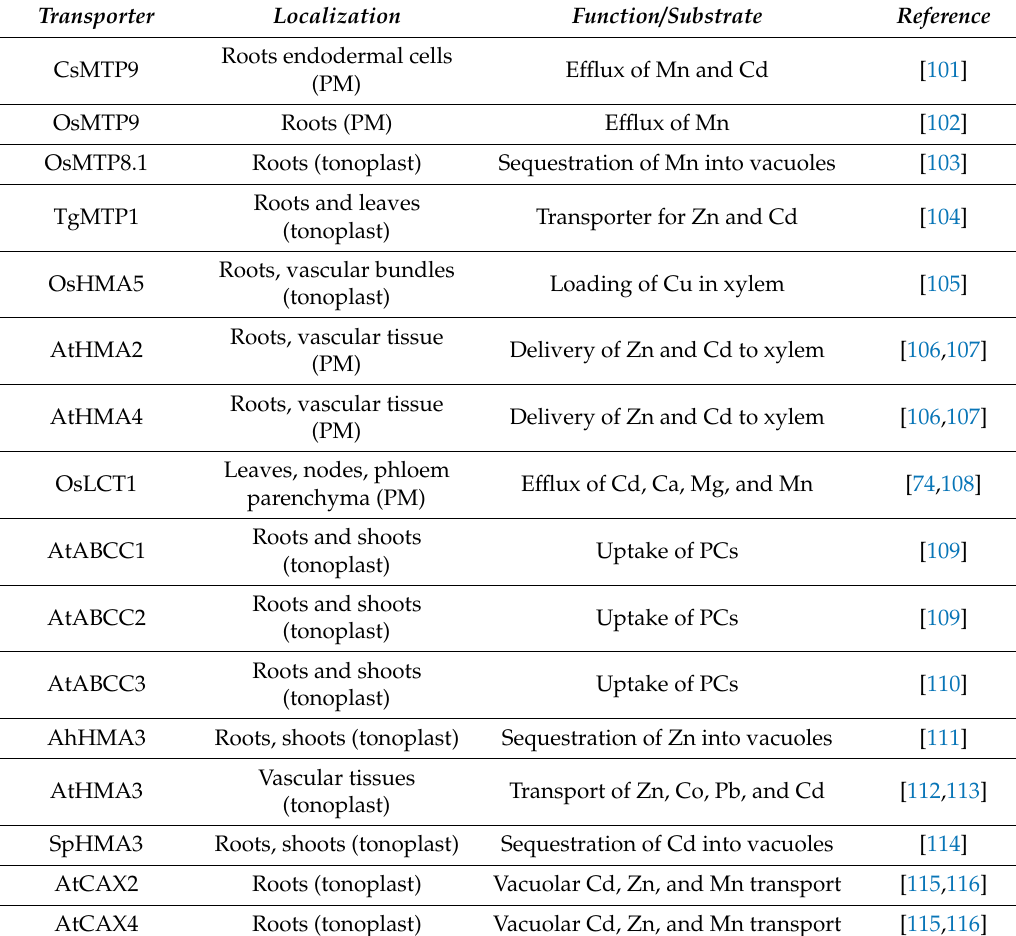
Abbreviations : PM, plasma